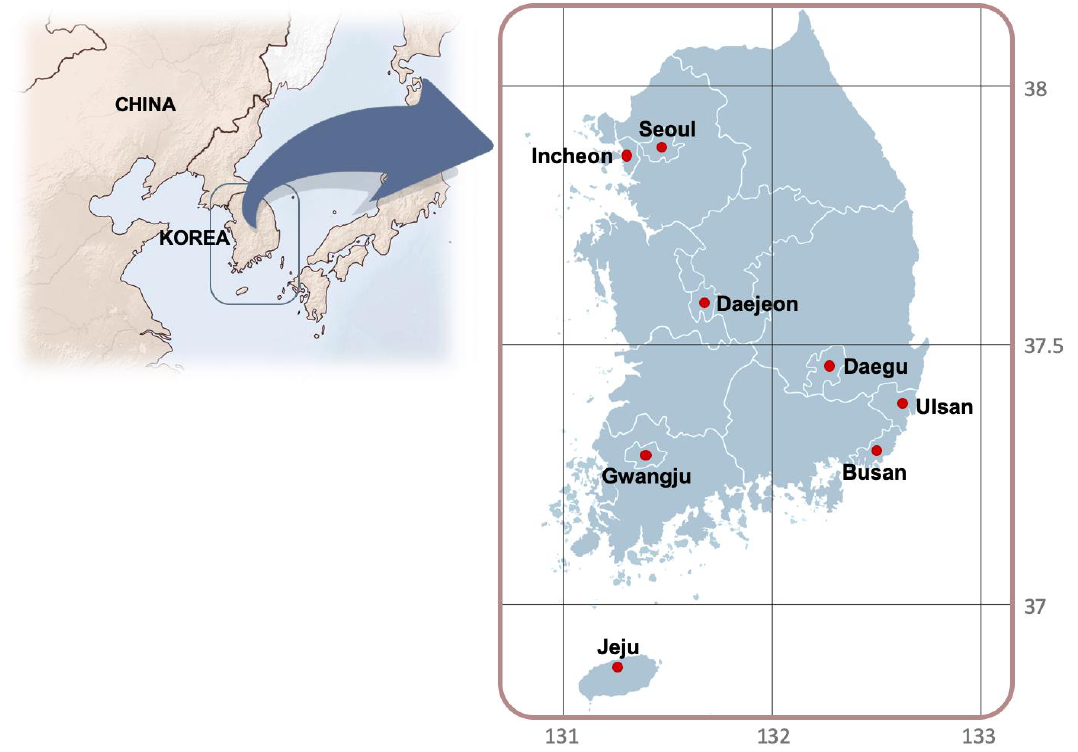
Figure 1. Location of the study regions in South Korea.